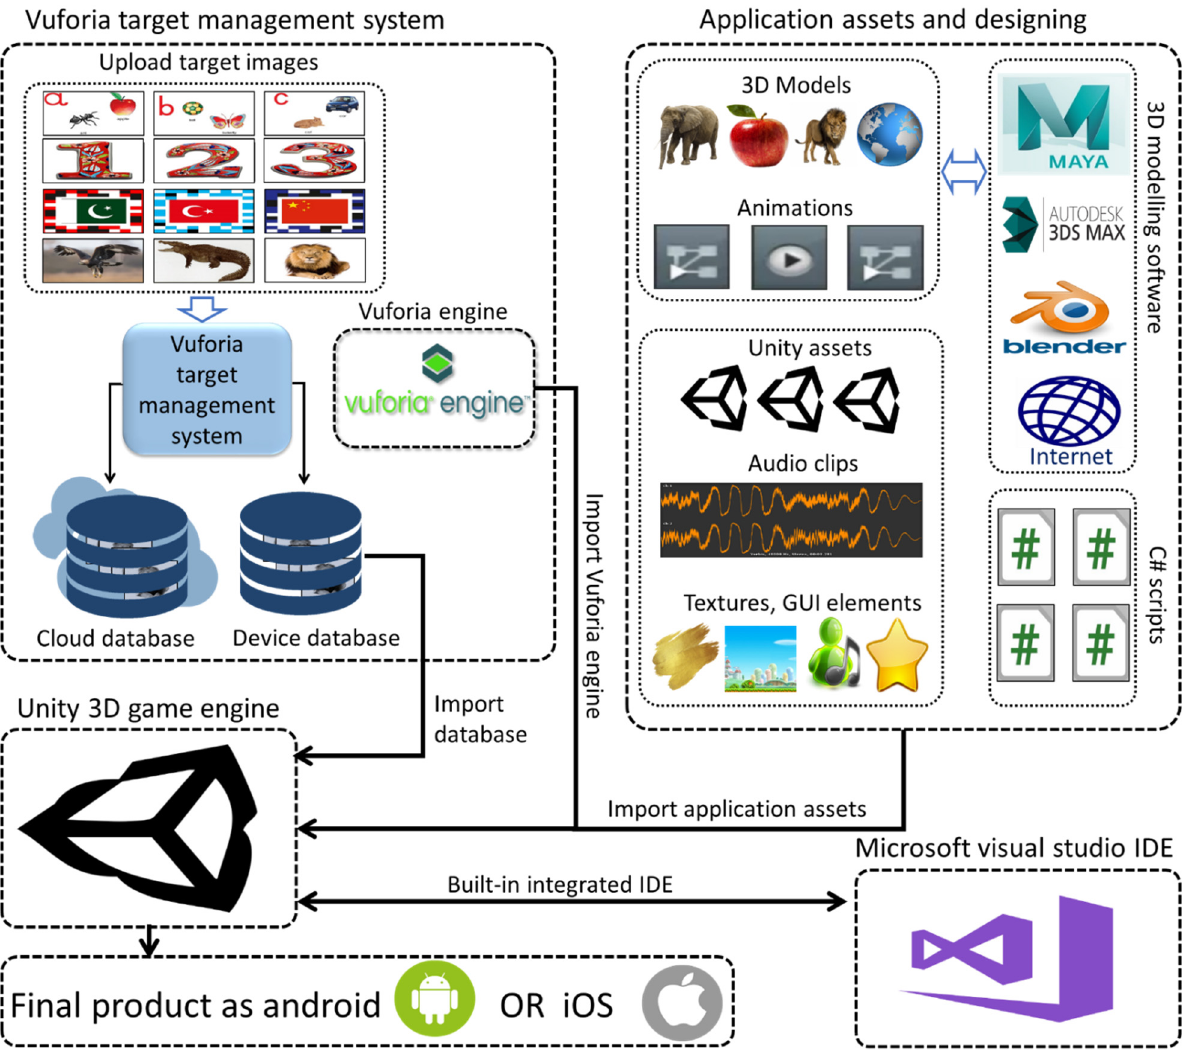
Figure 2. Designing and developmental phases of the proposed applications consist of a target management system where the target images database is prepared. All the application assets, 3D models, C# scripts, audio clips are prepared and merged into the Unity 3D engine. The final application is built as android or iOS.